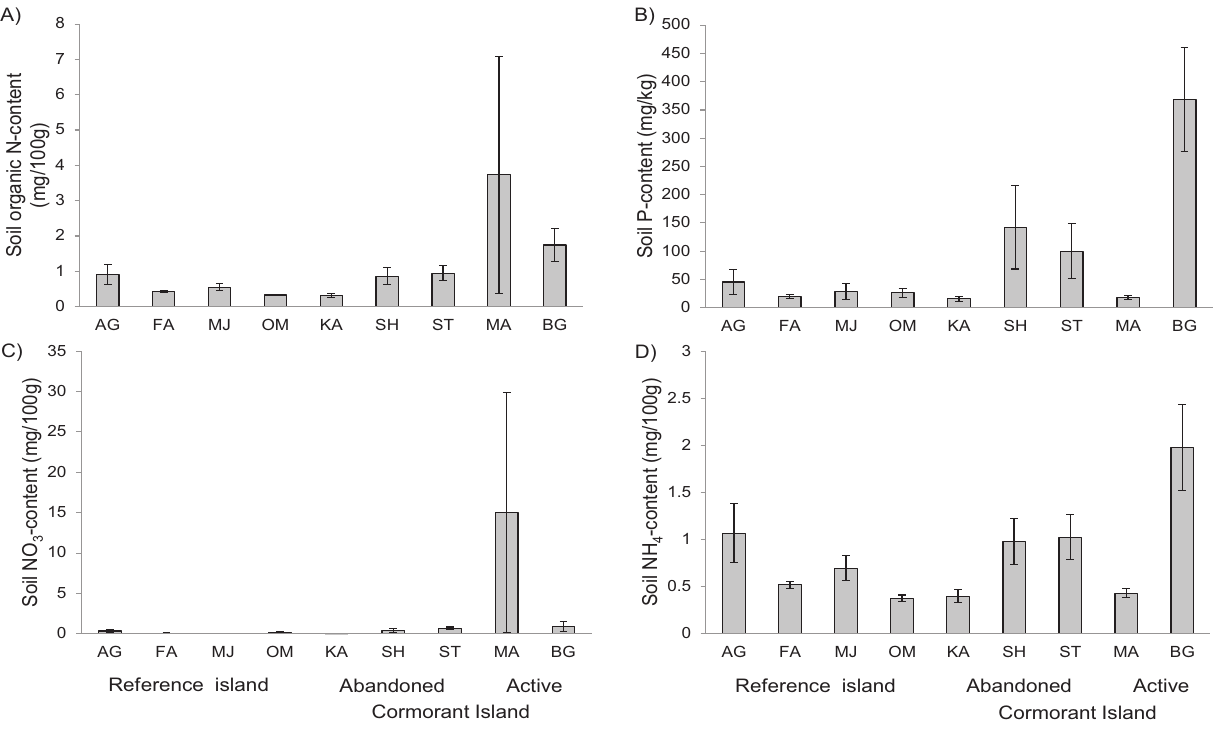
Figure 2. Soil nutrient contents (N, P, NO 3 , and NH 4 ) on four non-cormorant, three abandoned and two active cormorant islands in Stockholm